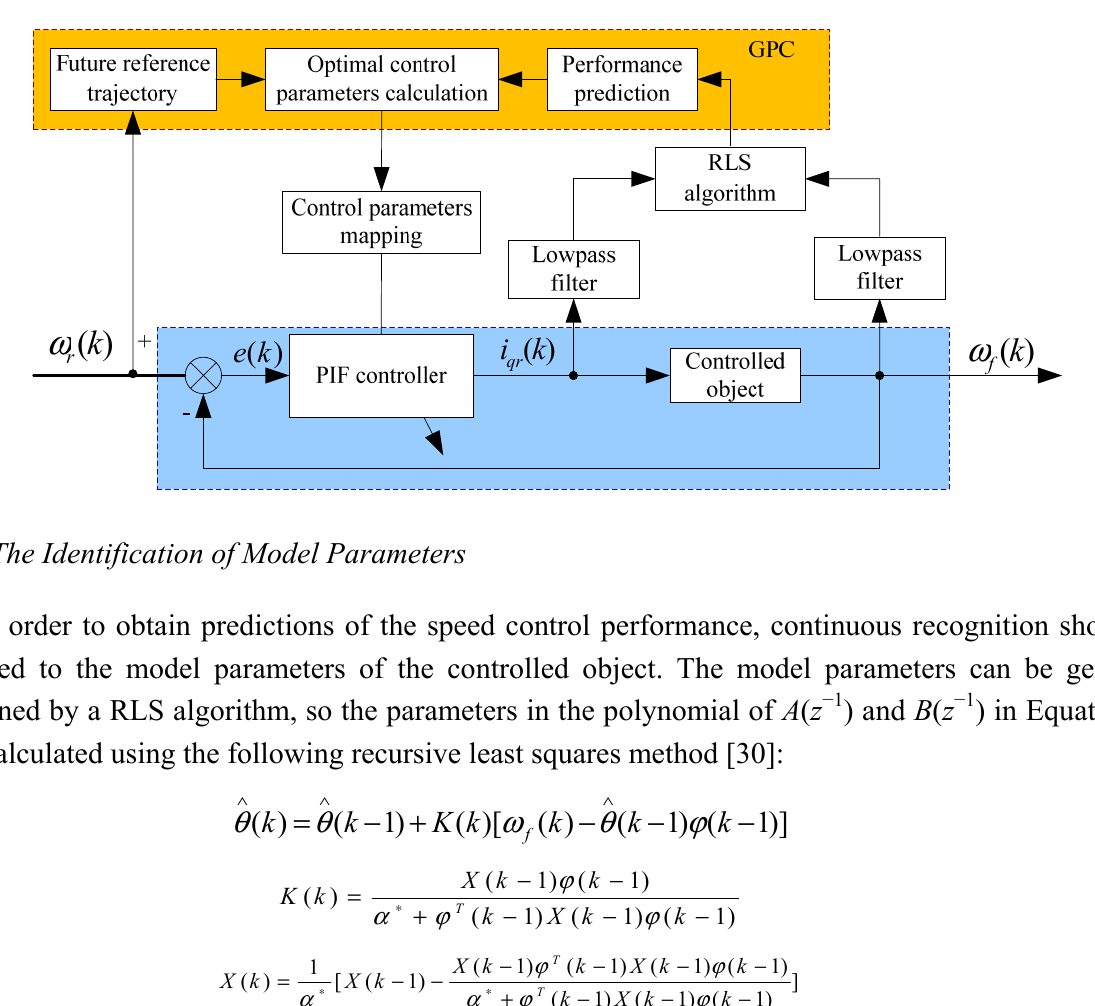
Figure 4. The principle diagram of a PIF control-based